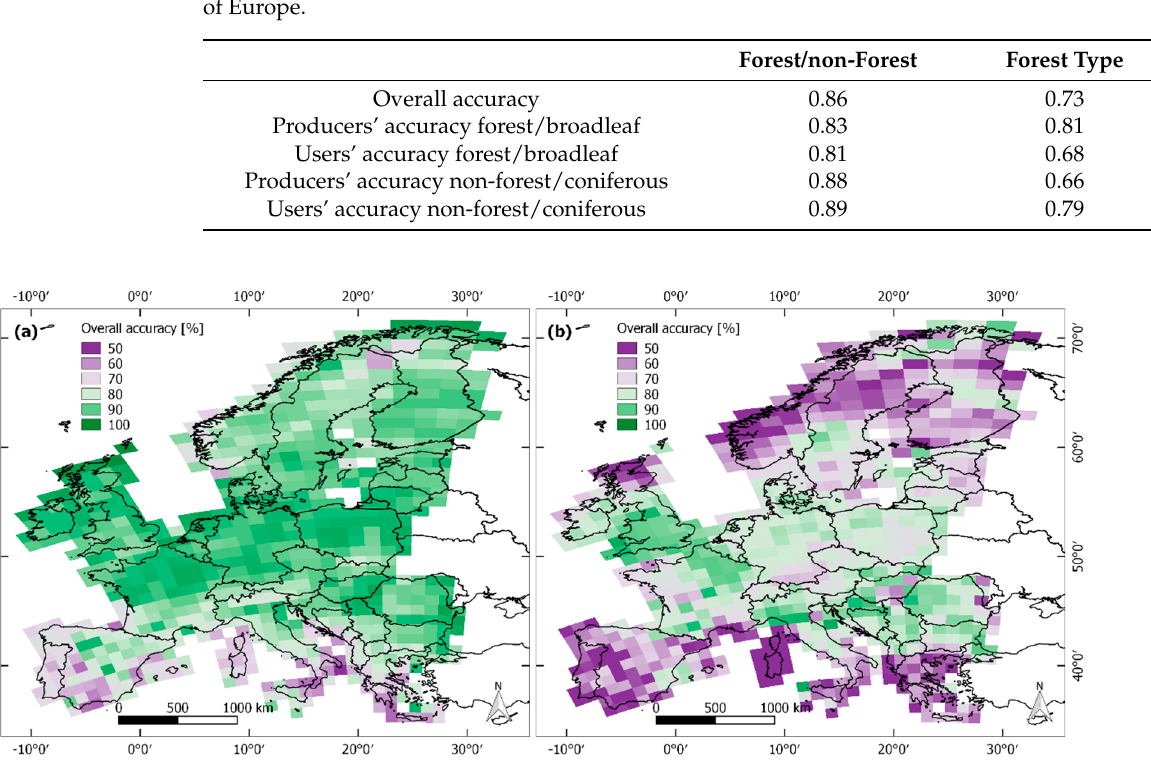
Figure 9. Overall accuracy of the Sentinel-1 ( a ) forest/non-forest and ( b ) forest type map computed for each Equi-1 tile. The Copernicus High Resolution Layers forest type dataset was used as a reference, showing the limitations of the presented maps for high latitudes and Mediterranean forests. Lower accuracies can also be observed in mountainous areas.